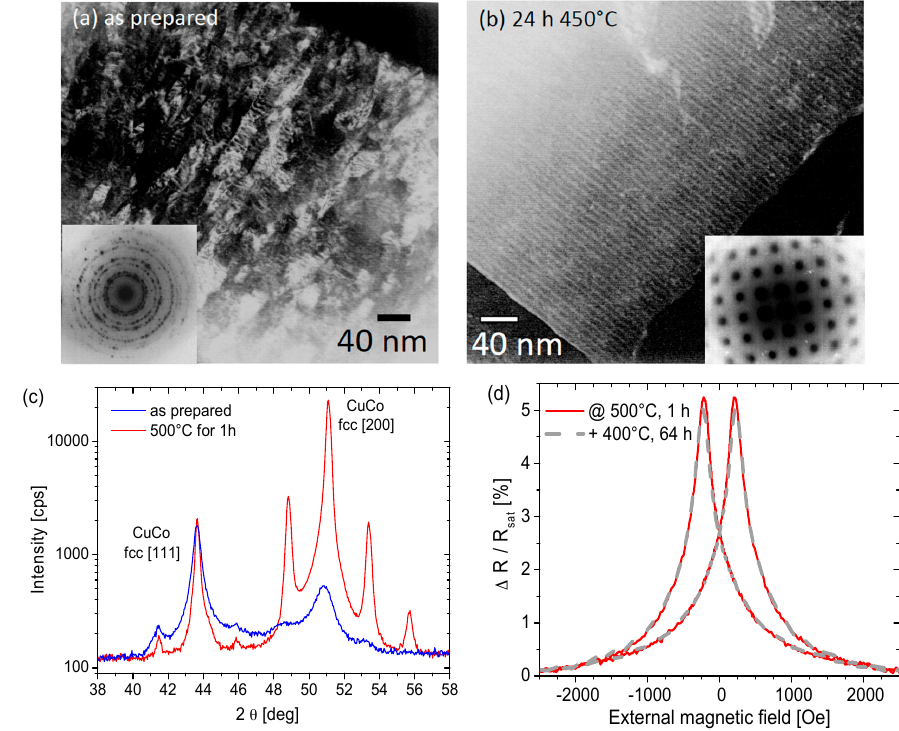
Figure 9. Comparison of TEM images of a [Py 3nm /Cu 6nm /Co 3nm /Cu 6nm ] 20 multilayer in the as prepared state ( a ) and after annealing at 450 °C for 24 h ( b ). The insets show the corresponding selected area